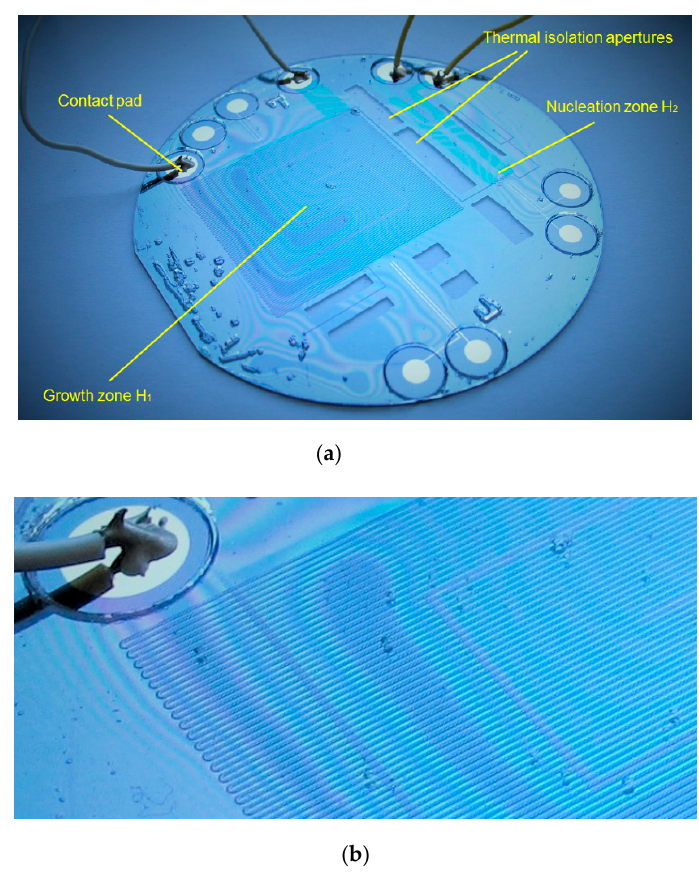
Figure 1. ( a ) Microreactor with integrated p-type diffused heaters in two different zones (the zone for nucleation with a smaller heater H 2 and the zone for the growth of nanoparticles with a larger heater H 1 ) with thermal isolation and metal contact pads and bonding wires; ( b ) enlarged view of the microreactor showing the network of microchannels etched in Pyrex glass, located above the heater.